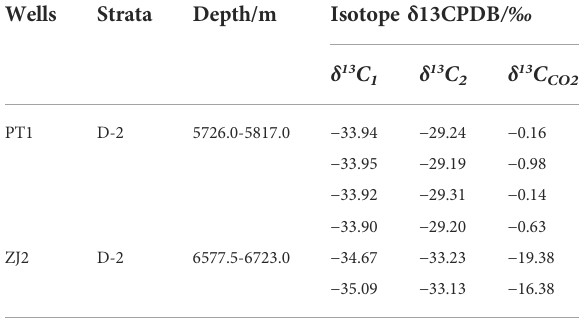
TABLE 1 Carbon isotopic values ( δ 13 C PDB ) of the natural gas from the Dengying Formation. Wells